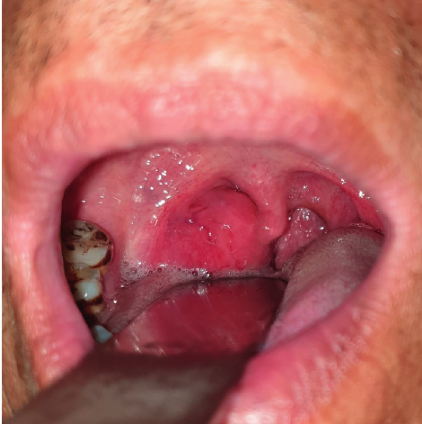
Figure 1: Picture showing the right oropharyngeal mass.